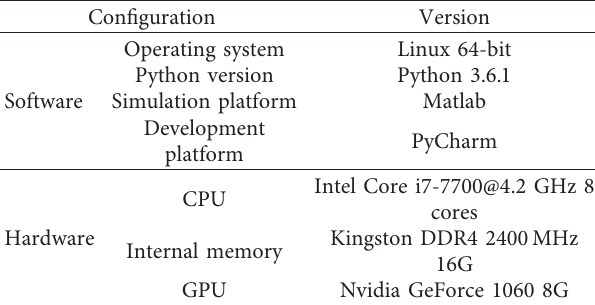
Table 1: Simulation environment